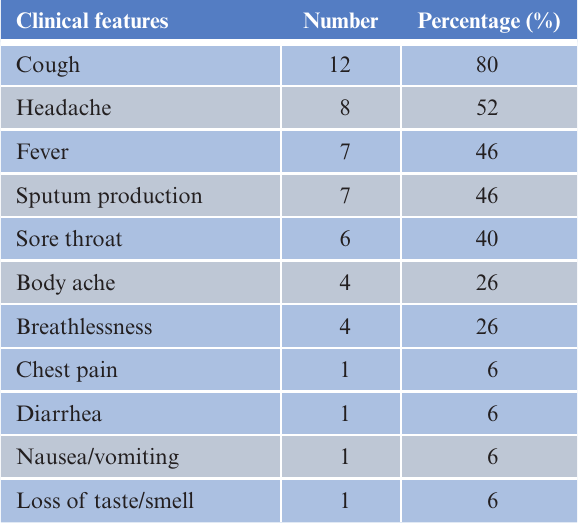
Table 2: Clinical presentation of COVID 19 in renal transplant